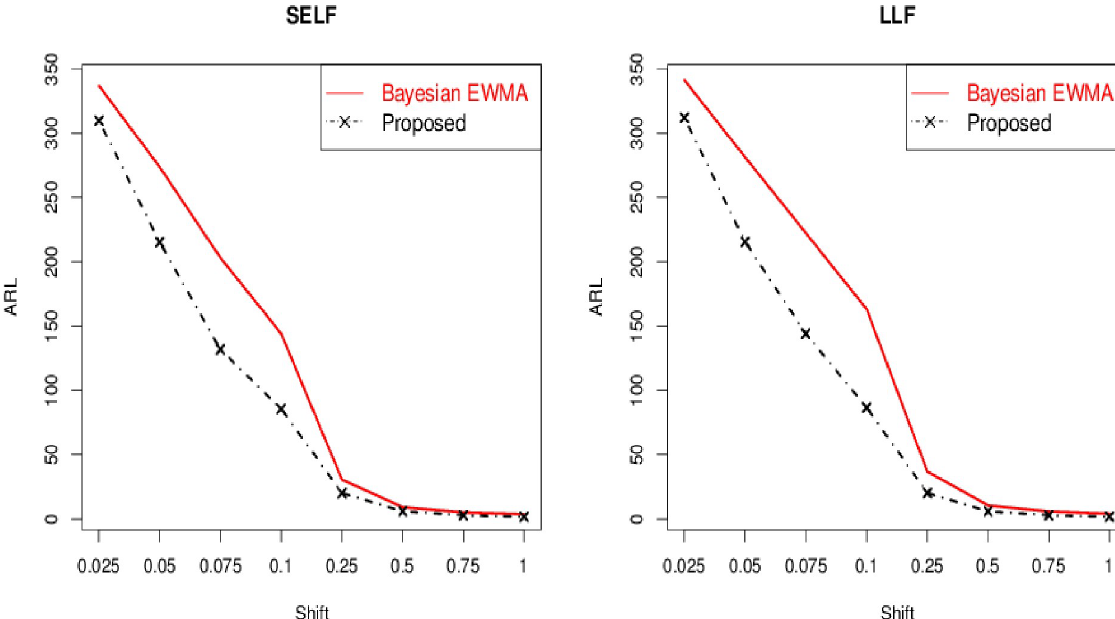
Fig 4. ARL comparison of proposed Bayesian modified EWMA chart with existing Bayesian EWMA for n = 5 and λ = 0.15 for various loss functions.